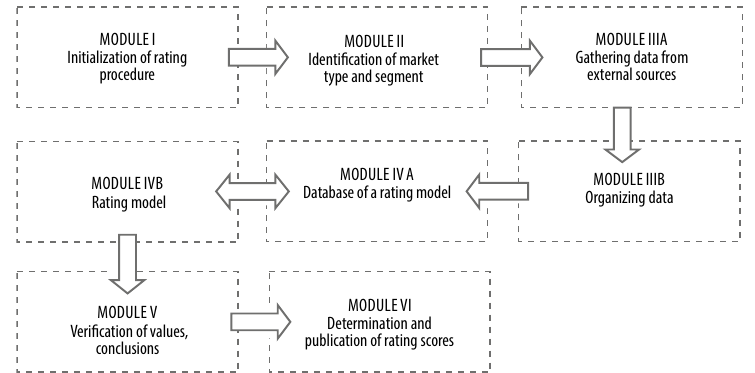
Fig. 1. Diagram of a rating procedure